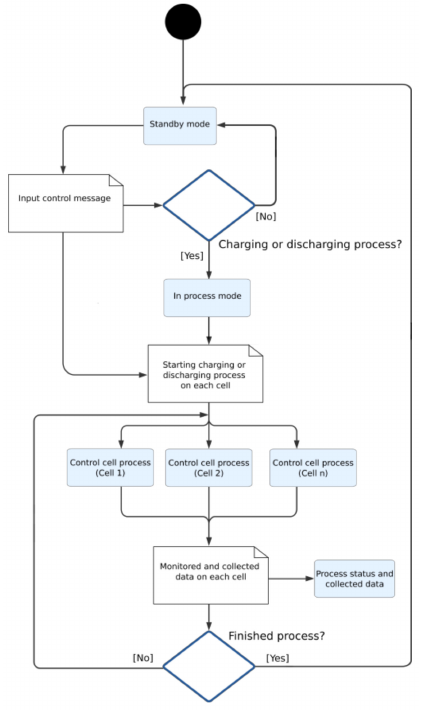
Figure 5. System control flow